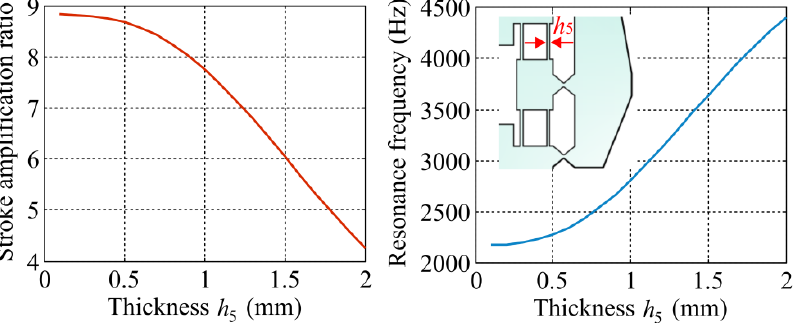
Figure 10. Theoretical results of the displacement amplification ratio and the main resonance fre- quency for the displacement amplification mechanism versus the thickness of guiding flexure beams.